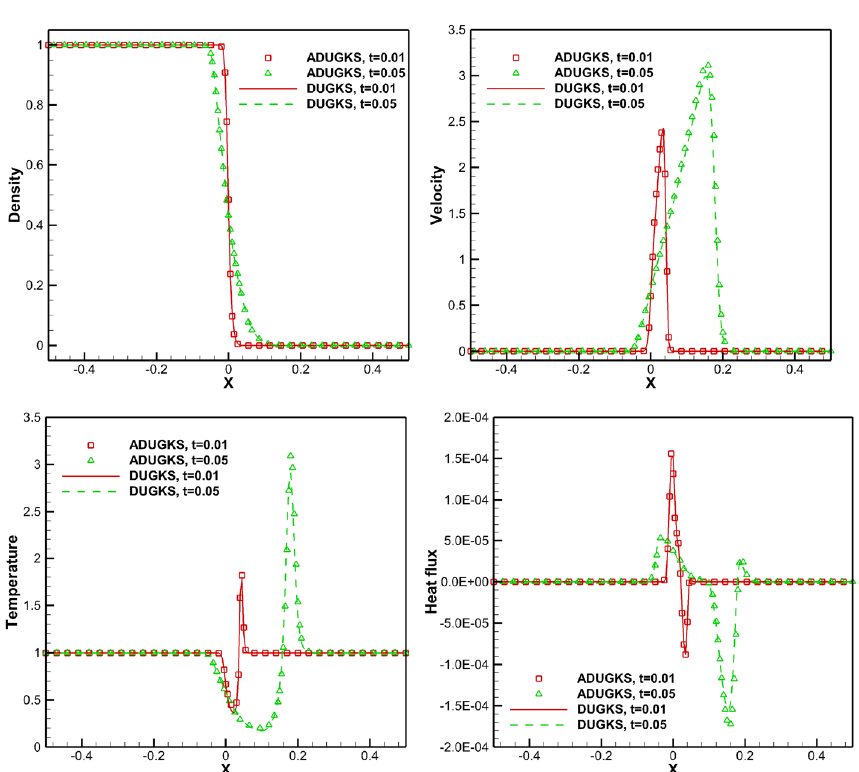
Fig. 21 Comparison of density, u -velocity, temperature and x -component of heat flux profiles along the horizontal central line of the channel at different